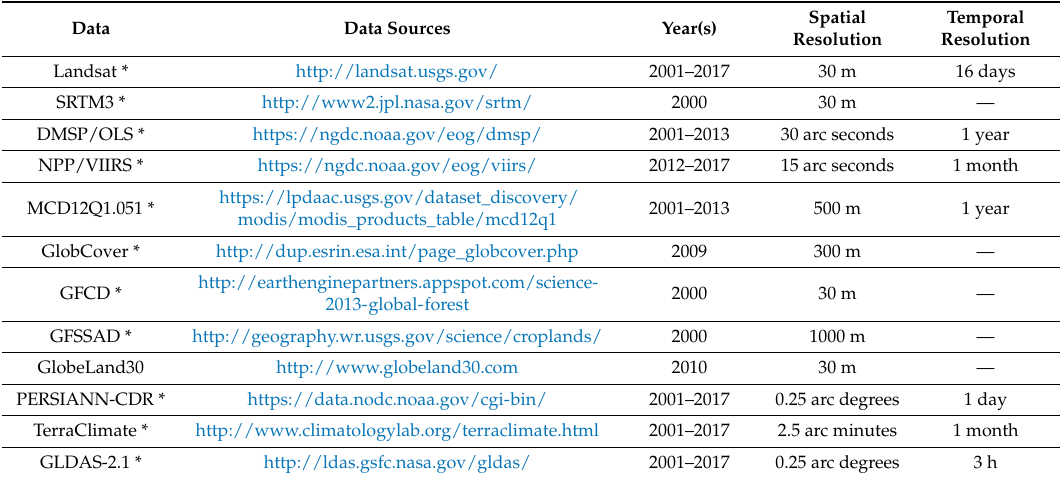
Table 1. Datasets Used in this Research. Note that Year(s) represents the temporal range of the datasets used; * represents data available online